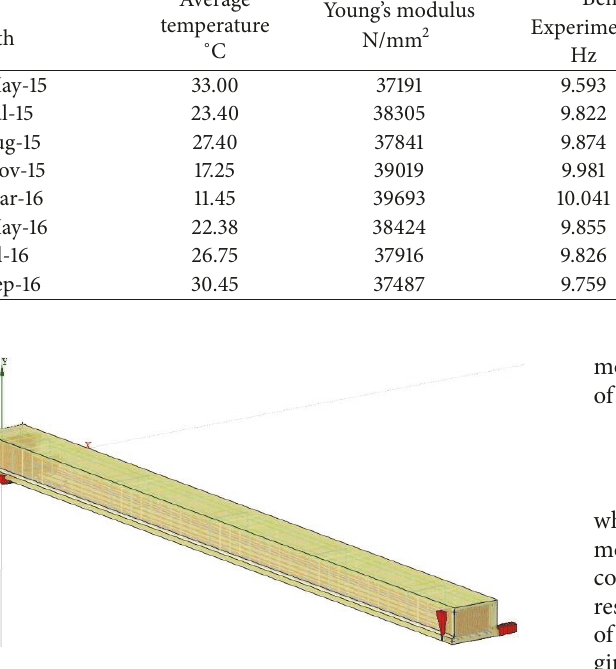
Figure 22: A 3D model of the PC